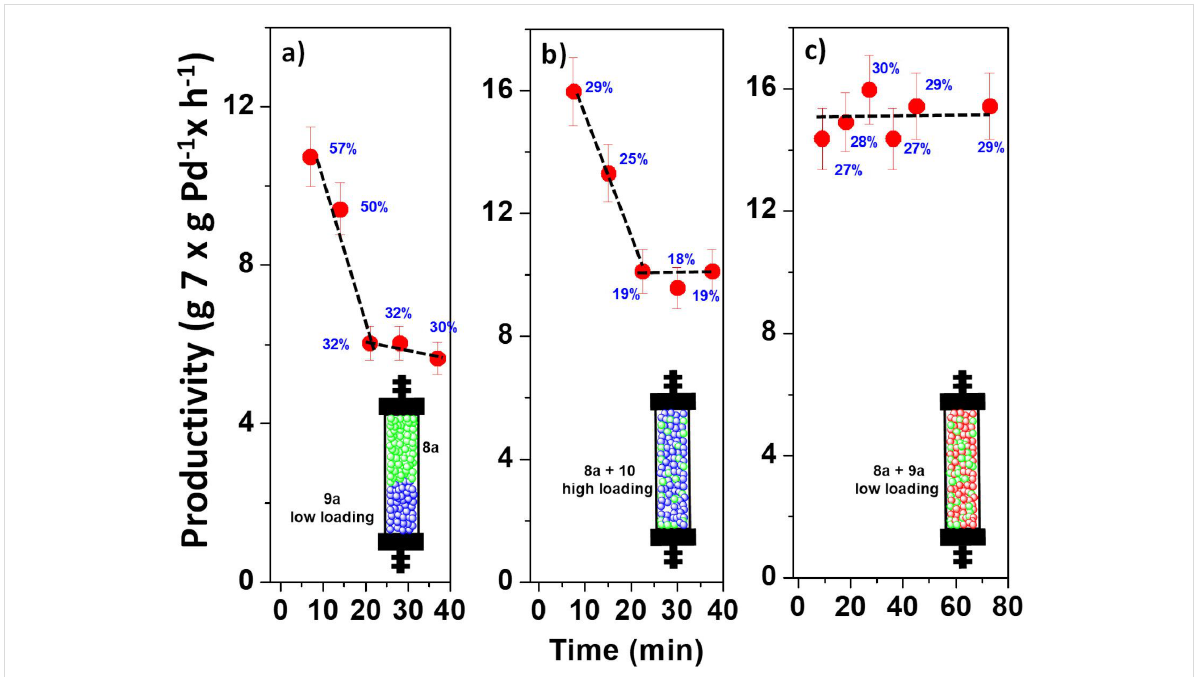
Figure 7: Negishi reaction between 5 and 6 under flow conditions catalyzed by 8a in the presence of a scavenger SILLP ( 9a and 10 ). a) 200 mg of 8a (top) and 200 mg of 9a (bottom). V = 0.535 mL, residence time = 2.5 min, productivity max: 18.84 g 7 × g Pd − 1 × h − 1 . b) 50 mg of 8a and 150 mg of 10 (mixed), V = 0.38 mL, residence time = 2.5 min, Productivity max: 53.24 g 7 × g Pd − 1 × h − 1 . c) 50 mg of 8a and 150 mg of 9a (mixed), V = 0.35 mL, residence time = 2.5 min, productivity max: 53.24 g 7 × g Pd − 1 × h − 1 . Yield calculated by GC and confirmed by 1 H